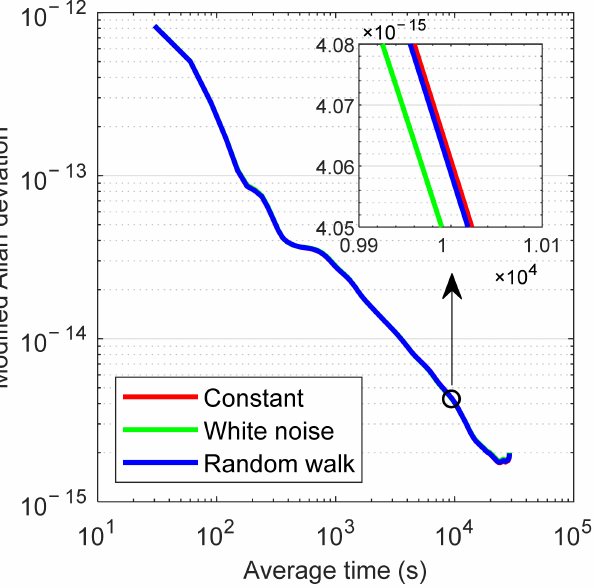
Figure 9. MDEV of the time link BRUX-SPT0 with three different IFB dynamic models on DOY 248, 2021.